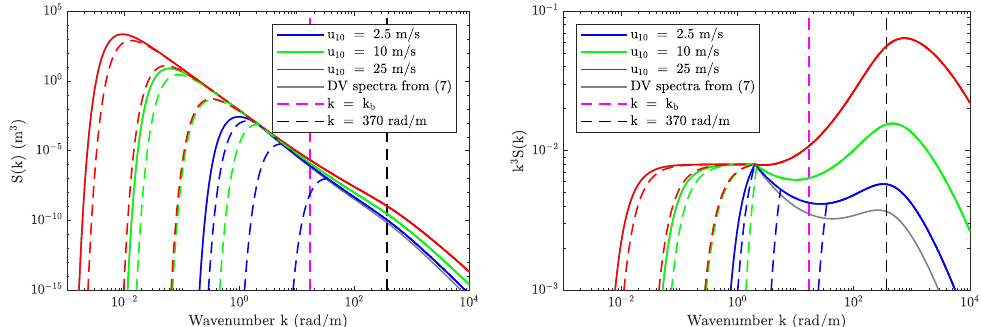
Figure 14. The modified Durden–Vesecky spectra ( left ) and curvature spectra ( right ) for different wind speeds (solid color curves) and Ω c values (dashed color curves). For each set of three dashed curves, the left-most, middle, and right-most curves represent Ω c = 1, Ω c = 2, and Ω c = 5, respectively. The gray solid curves show corresponding fully-developed DV spectra defined in (7). Note that gray curves for u 10 = { 10,25 } m/s are not visible, as (39) fully recovers (7) under those conditions. See text for